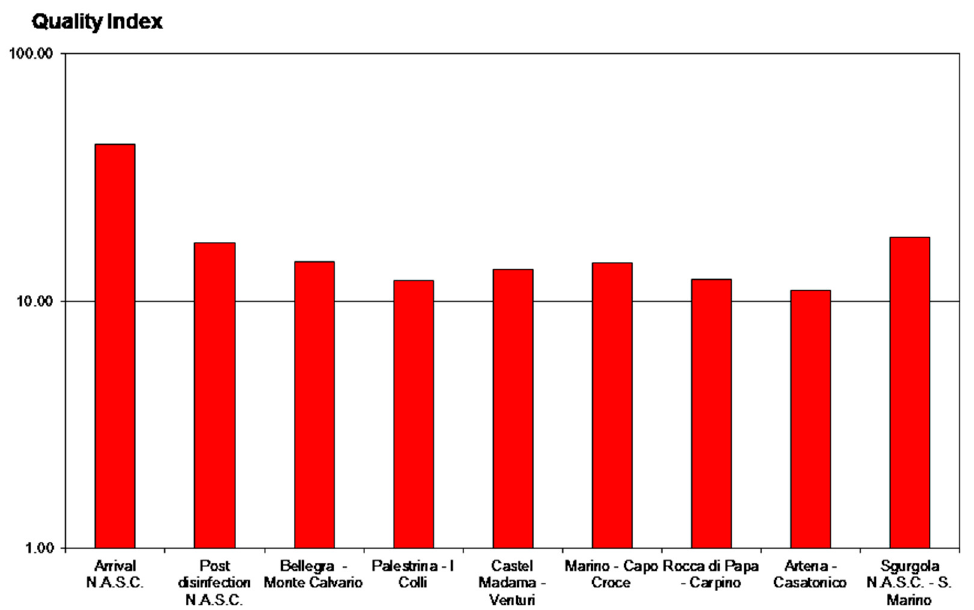
Figure 1. Quality index of the supply network located in Central Italy.